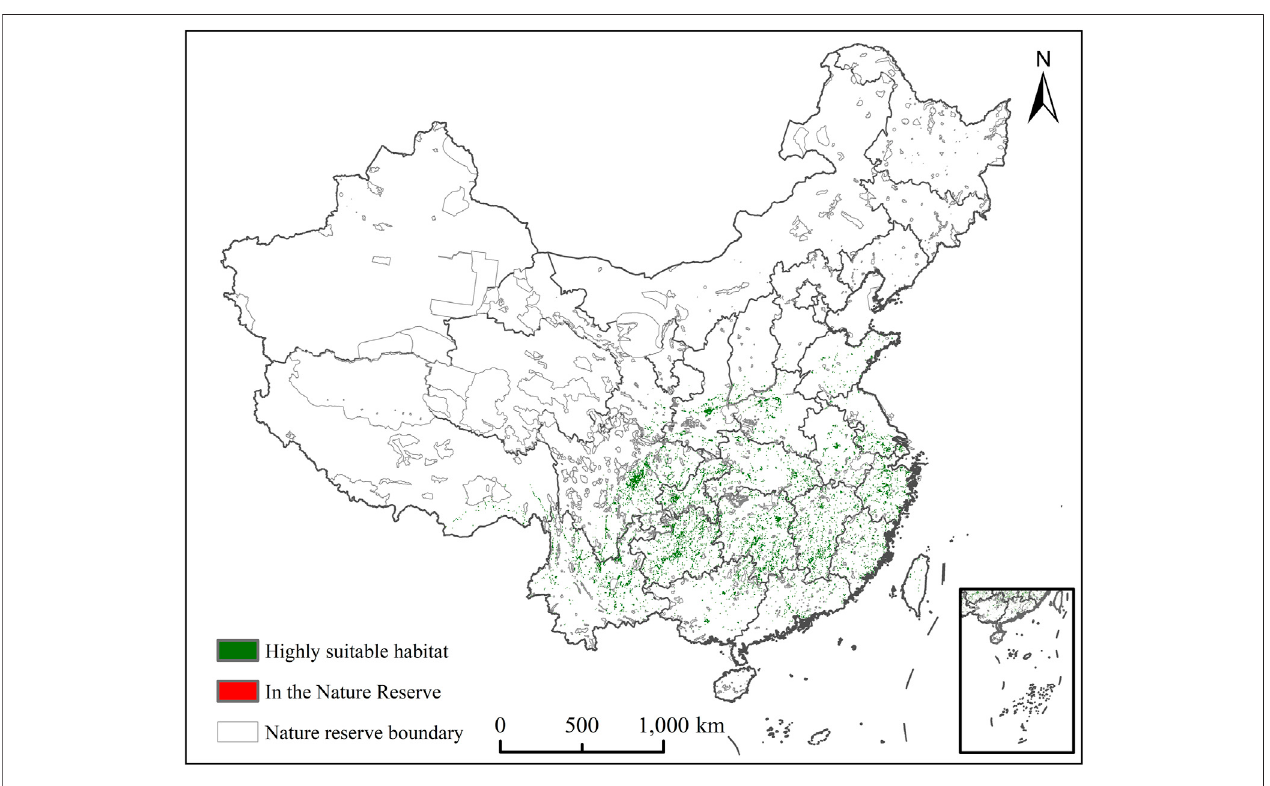
FIGURE 7 | Protection vacancy map of Cremastra appendiculata .